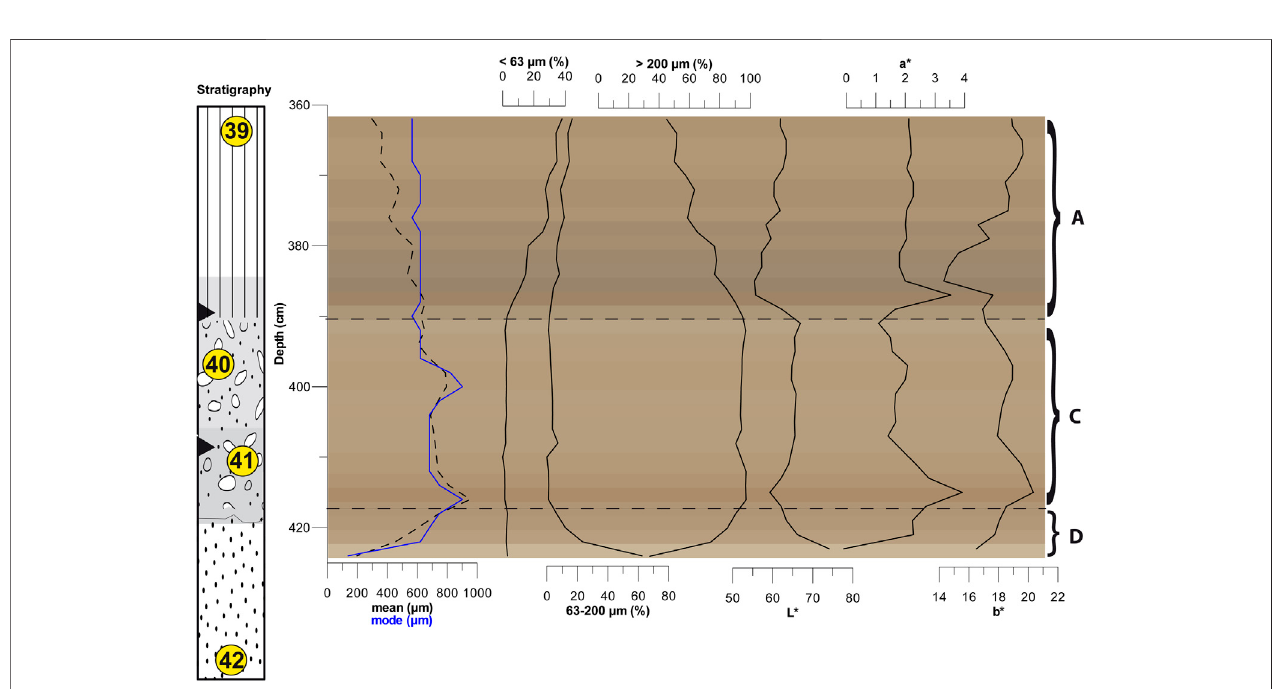
FIGURE9| Proxy dataofAttrench5showingthemeanand mode,grainsizedistributioninclasses < 63,63 – 200,and > 200 µm andthespectrophotometric color data (L, a*, b*). Measured colors are plotted in the background using the ‘ drawPro fi le.R ’ R script (Sprafke, 2016; Zeeden et al., 2017). A simpli fi ed sketch of the stratigraphy is shown on the left and the stratigraphic units are indicated by A – D (see legend in Figure 2 ).